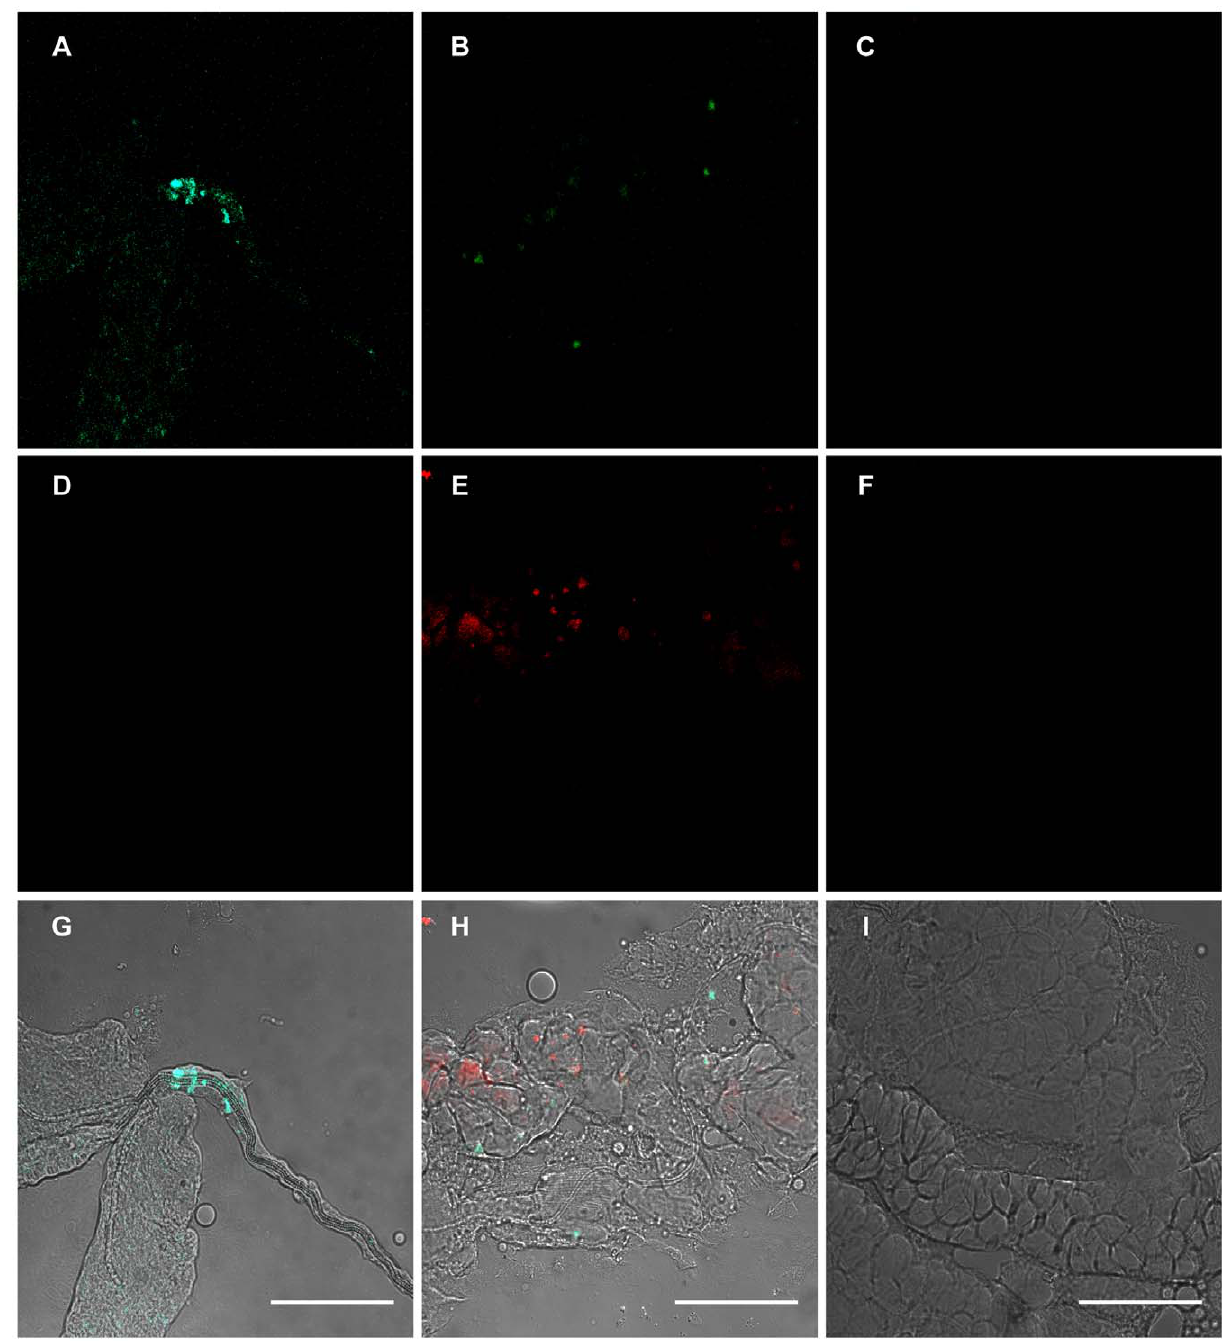
Figure 5. Localization of Wolbachia and DENV-2 in Ae.albopictus. At 14 days post-DENV-2 infection, salivary glands were dissected, fixed, and then incubated simultaneously with two Wolbachia probes and two DENV specific probes. In panels A, B, and C, DENV-2 (green) is labeled with FITC. In panels D, E, and F, Wolbachia (red) is stained with Rhodamine. In panels G, H, and I, the red and green channels are merged. A co-localization of Wolbachia and DENV-2 was detected in some cells (panel H). DENV-uninfected and Wolbachia -uninfected controls are presented in panel C and F, respectively. Scale bars: 50 m m.